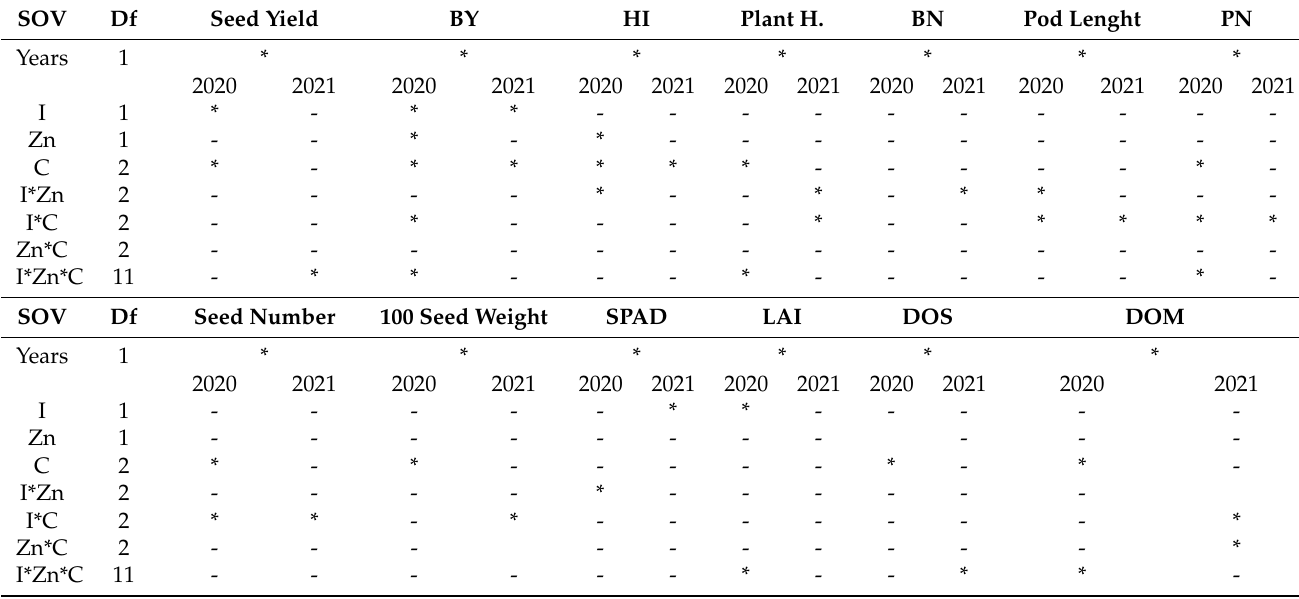
Table 2. ANOVA of grain yield and yield